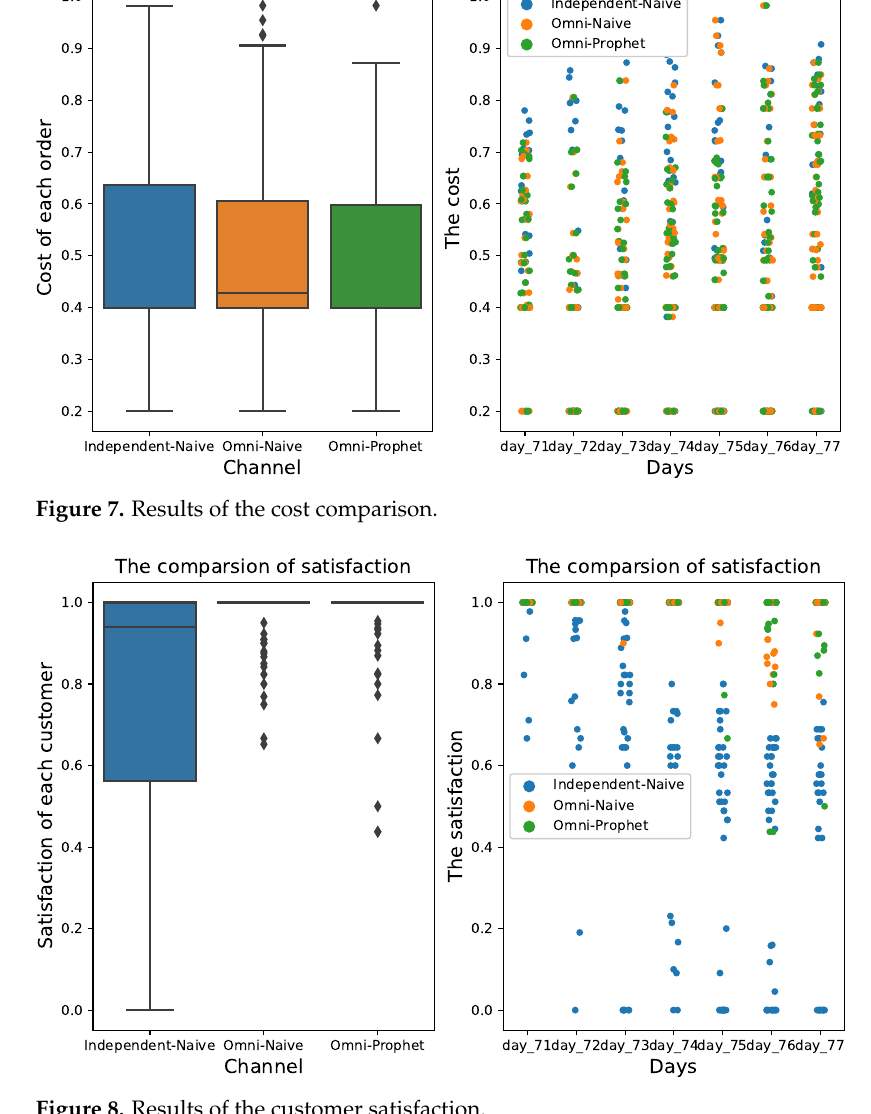
Figure 8. Results of the customer satisfaction. Table 7. Performance comparison considering forecasting methods and channel